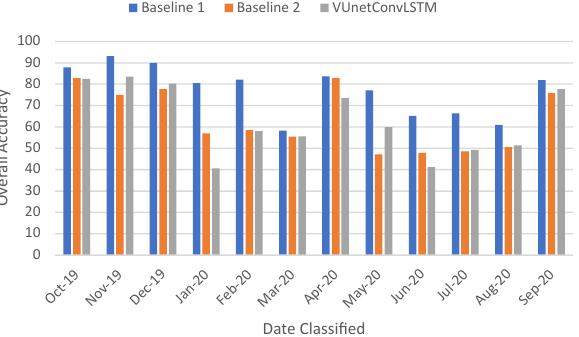
Figure 6. Reference crop parcels in LEM 17/18 dataset. All the polygons were used for training the Baseline 2 and